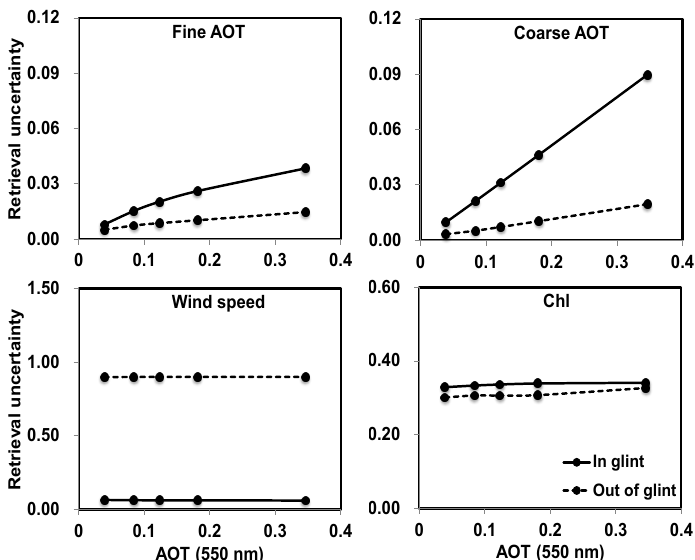
Figure 9. Simulated retrieval absolute uncertainties (components of ˆ S ) as a function of total AOT at 550nm. Results using sunglint observa- tions are shown in solid lines, and those from out of sunglint are in dashed lines.